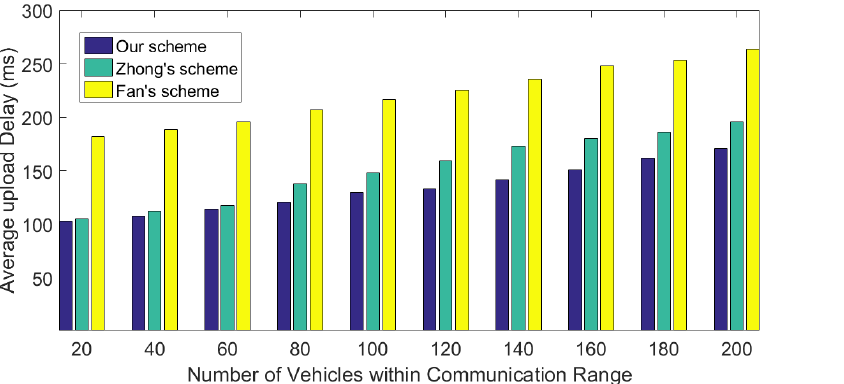
Figure 7. Upload data protocol.